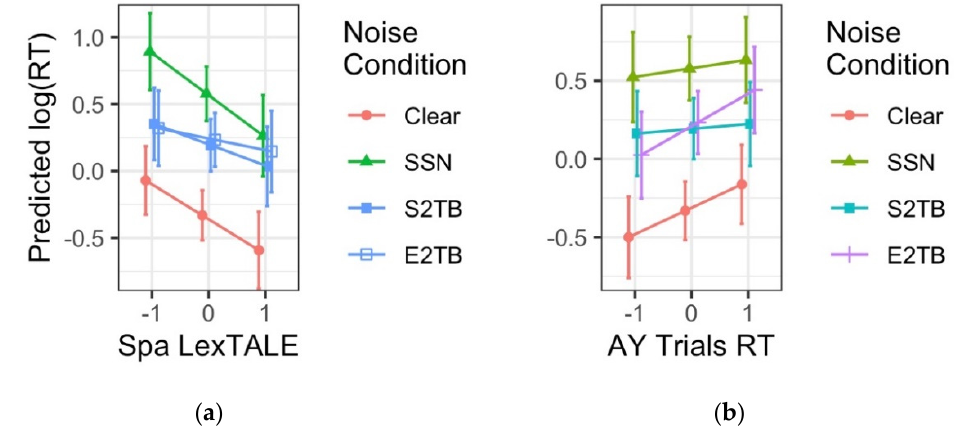
Figure 4. Estimated marginal means from the fitted IDs model depicting ( a ) the interaction between Noise Condition and Spanish LexTALE performance (an index of Spanish proficiency), and ( b ) the interaction between Noise Condition and AX-CPT performance (AY Trials RT, an index of inhibitory control). In ( a ), listeners with higher Spanish proficiency had faster RTs overall, and showed no difference between the SSN and 2TB conditions. In ( b ), listeners with less-efficient inhibitory control (i.e., higher values for AY Trials RT) were disproportionately affected by E2TB. (SSN = speech-shaped noise, S2TB = Spanish two-talker babble, E2TB = English two-talker babble).